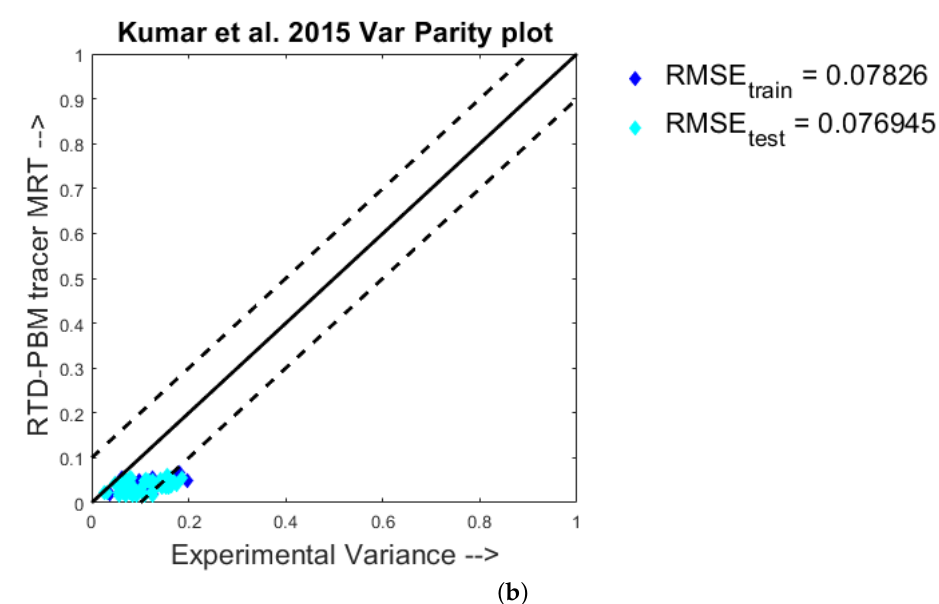
Figure 3. Experimental observations (X) vs. predicted model responses (Y) for RT metrics when model is trained on the Kumar et al., 2015 [18] dataset. ( a ) MRT; ( b ) variance.